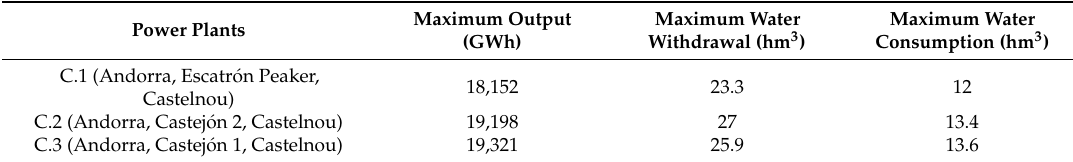
Table 6. Set of combinations in Scenario